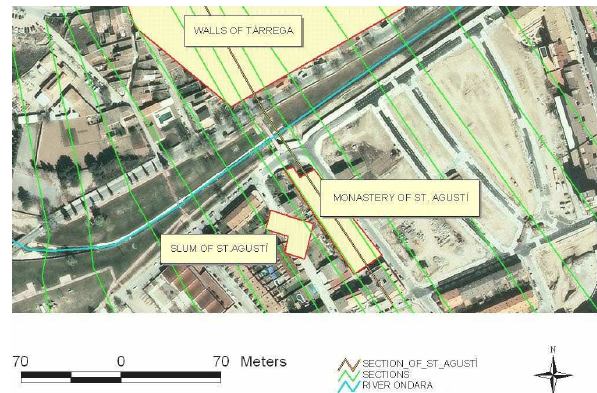
Fig. 8. Aerial photograph of the Ondara river channel (blue line) at T`arrega with the location of the Sant Agust´ı Bridge, cross section (brown line) and the rest of cross sections (green lines) used in the hydraulic modelling. This figure shows as well the alleged location of the external walls of the city and the disappeared Sant Agust´ı monastery and nearby buildings according to the archaeological re-